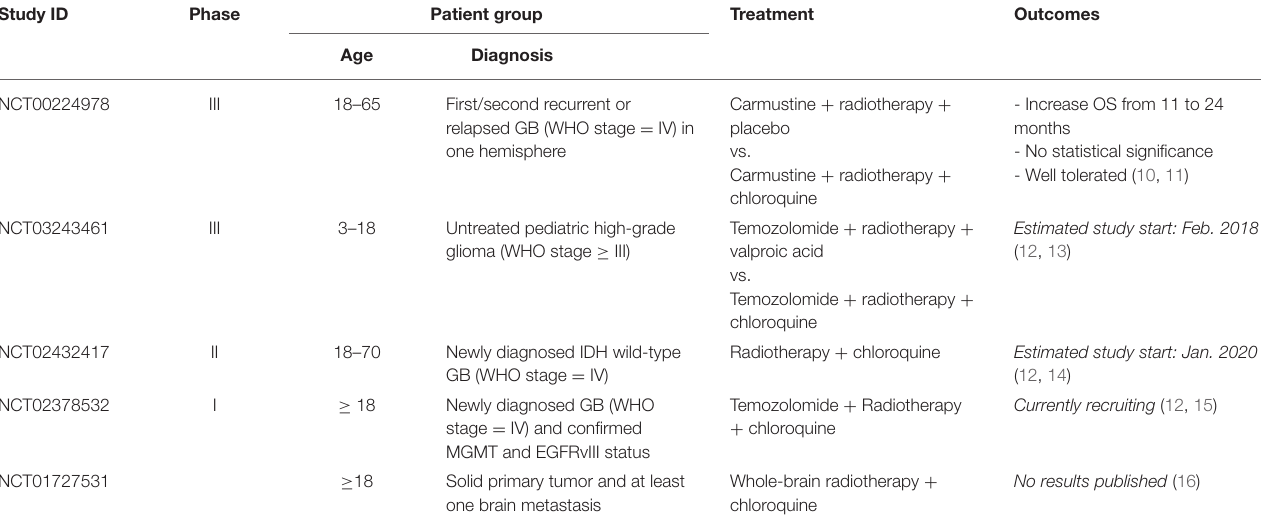
TABLE 1 | Summary of clinical trials testing chloroquine in